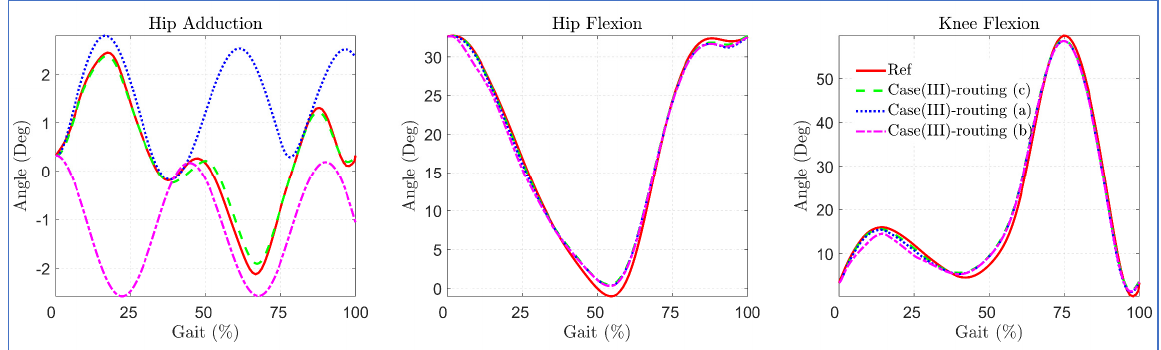
Figure 11. Trajectory tracking with various ways of cable routing of the case (III) of 4-cable config- uration.